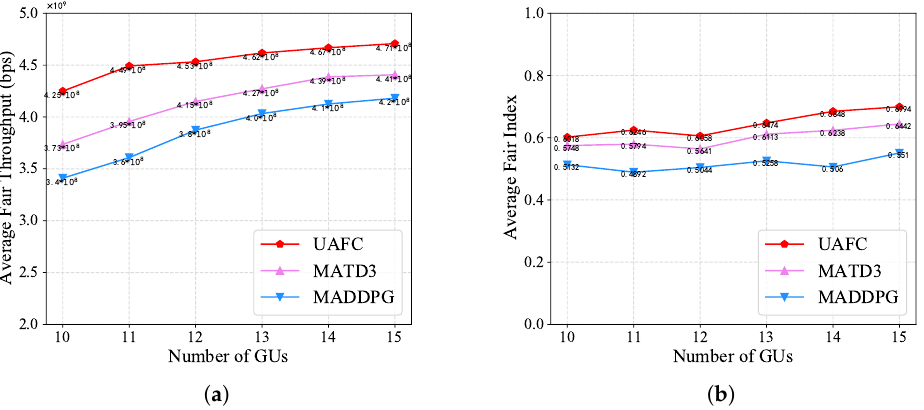
Figure 8. The impact of the number of GUs on system performance. ( a ) Average fair throughput. ( b ) Average fair